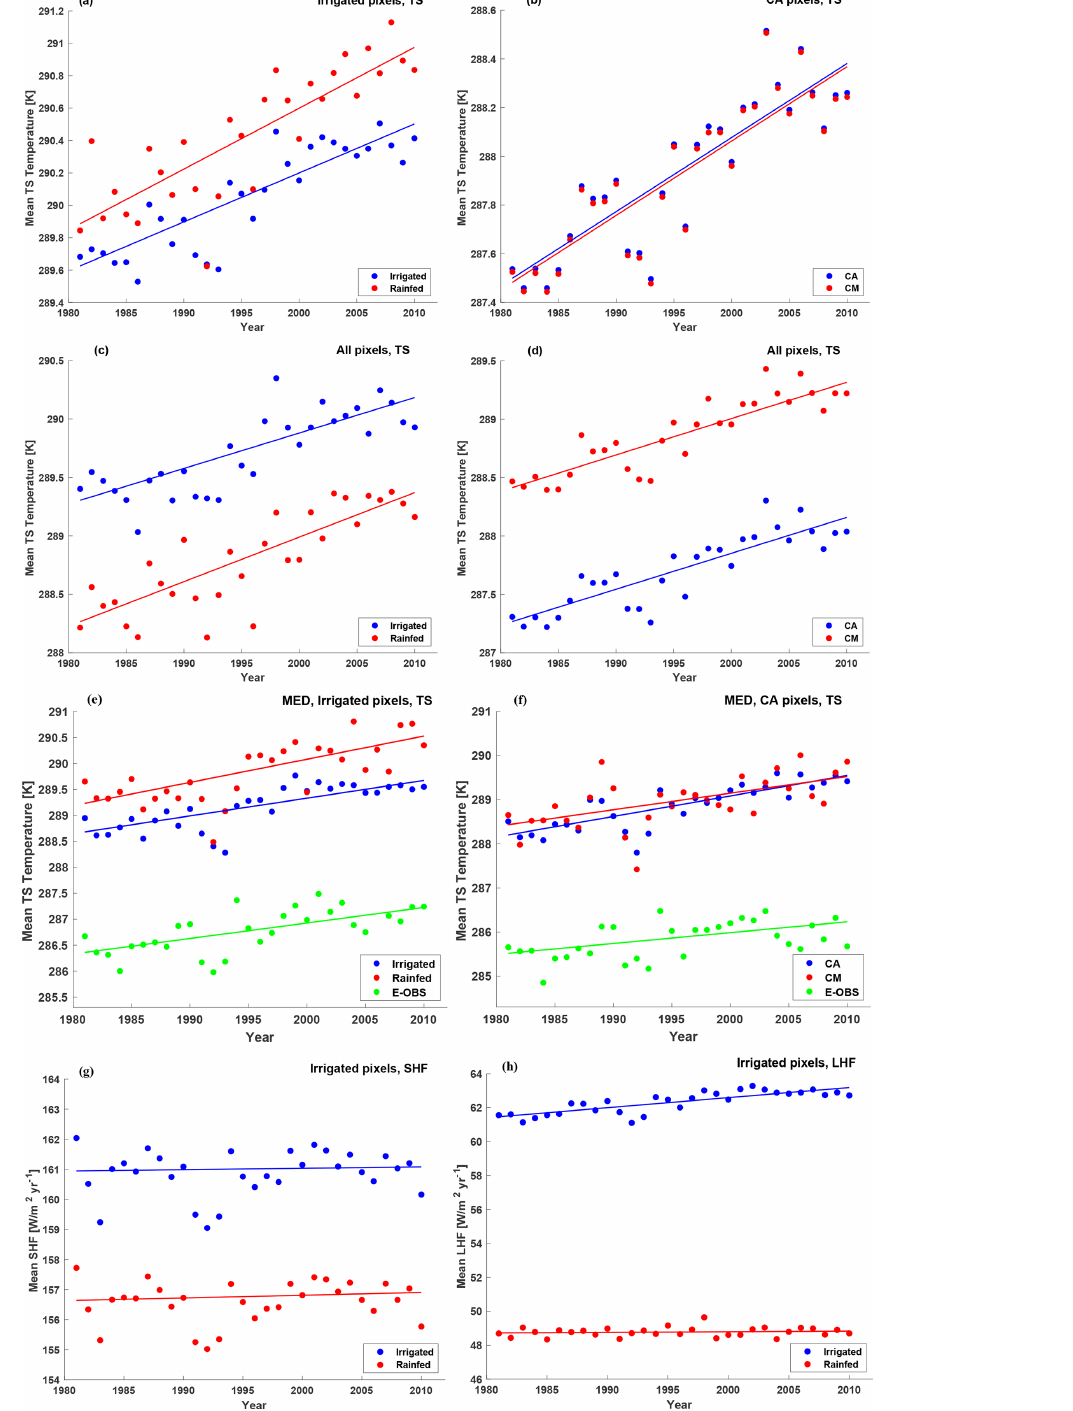
Figure 7. Average of the subgrid-scale warming rates for surface radiative temperature (TS) (a–f) , the SHF (g) and LHF (h) over (a, g) irrigated pixels for the irrigated and rainfed crop tiles; (b, h) CA pixels for the CA and CM crop tiles; (b) all pixels for the irrigated and rainfed crop tiles; (d) all pixels for the CA and CM crop tiles; (e) irrigated pixels over the MED SREX region; and (f) CA pixels over the MED SREX region. Data points are the mean TS, LHF and SHF values within the crop tiles and pixels specified. The slope was estimated using Sen’s slope for the rainfed/CM (red), irrigated/CA (blue) experiments. For (a) , (b) , (c) , (d) , (e) and (f) the regions where less than 50% of the land pixels did not contain a value were excluded. For all land pixels (g, h) , the minimum number of land pixels that needed to contain a value in order to be retained in the analysis was